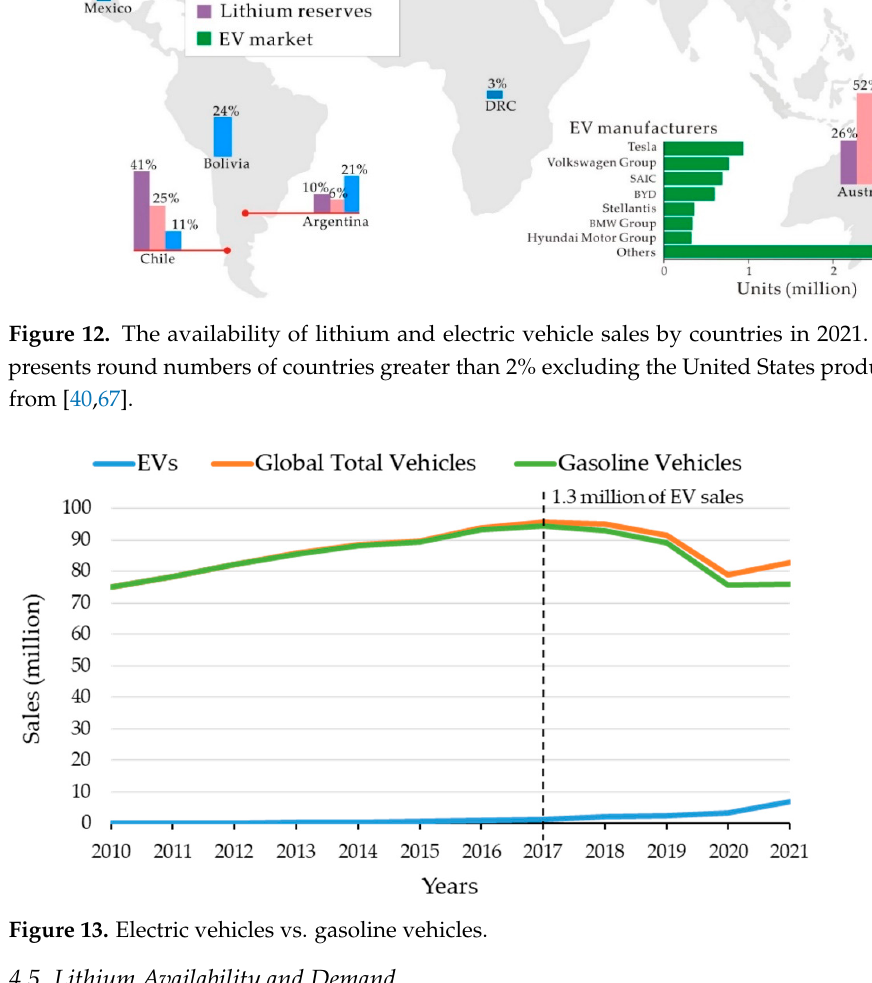
Figure 13. Electric vehicles vs. gasoline